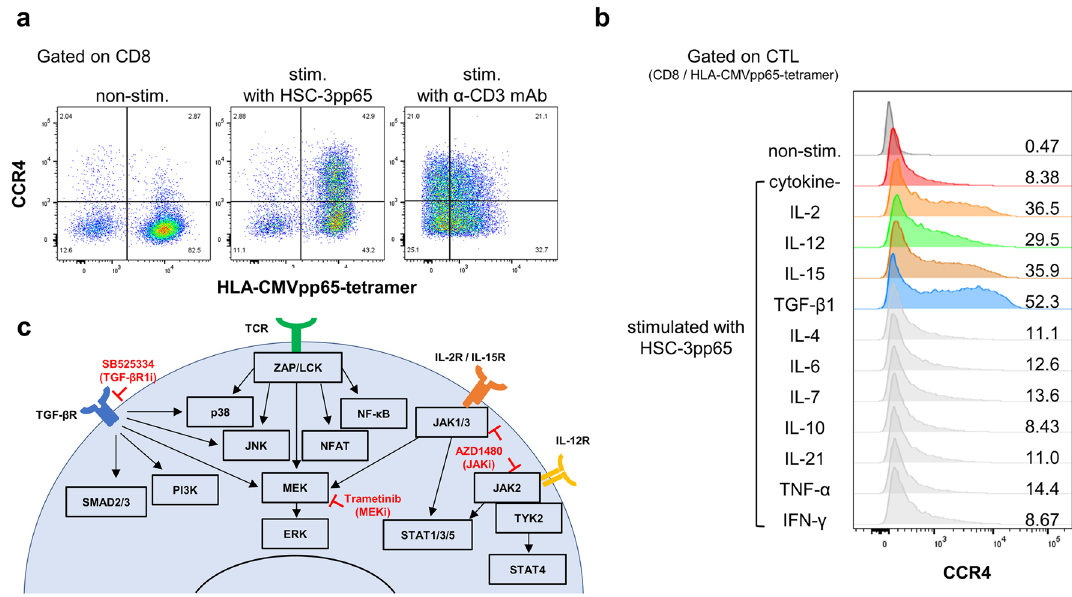
Figure 1. CCR4 expression in CTLs was induced by TCR and cytokine signaling. CMV-CTLs derived from PBMC of HD1 were stimulated with HSC-3pp65 cells or stimulated by immobilized anti-CD3 mAb. On day 2, flow cytometry was performed. CCR4 expression in CMV-CTLs without cytokines ( a ) and with ( b ) are shown. The receptors required for CCR4 expression obtained from the results in ( a,b ), their signaling pathways, the inhibitors used for the experiments in this study, and the sites of action are shown below ( c ). CCR4 CC chemokine receptor type 4, TCR T-cell receptor, CMV Cytomegalovirus, CTL cytotoxic